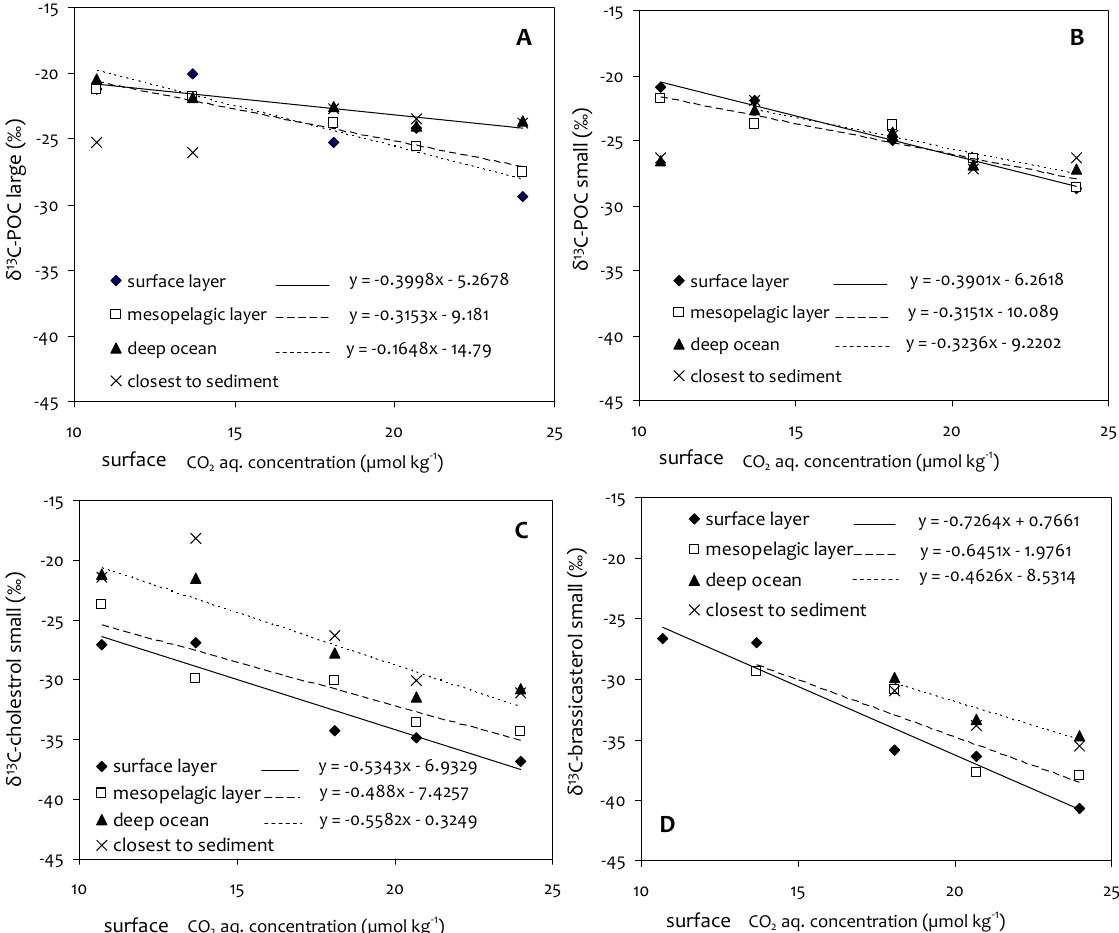
Fig. 5. Upper panel: relationship between surface water (0–100m) CO 2 aq. concentration (µmolkg − 1 , Table 1) and δ 13 C POC (‰) in large ( > 53µm) (A) and small (1–53µm) (B) particles in surface water (0–100m, closed diamonds), mesopelagic layer (100–1000m, open squares), deep ocean ( > 1000m, closed triangles), and bottom waters (crosses). Lower panel: relationship between surface water CO 2 aq. concentration and small particles (1–53µm) δ 13 C cholesterol (C) and δ 13 C brassicasterol (D) in surface water (0–100m, closed diamonds), mesopelagic layer (100–1000m, open square), deep ocean ( > 1000m, closed triangles), and bottom water (crosses). Averages ( ± 1 σ ) are given in Table 2. Standard errors are not shown here for the sake of